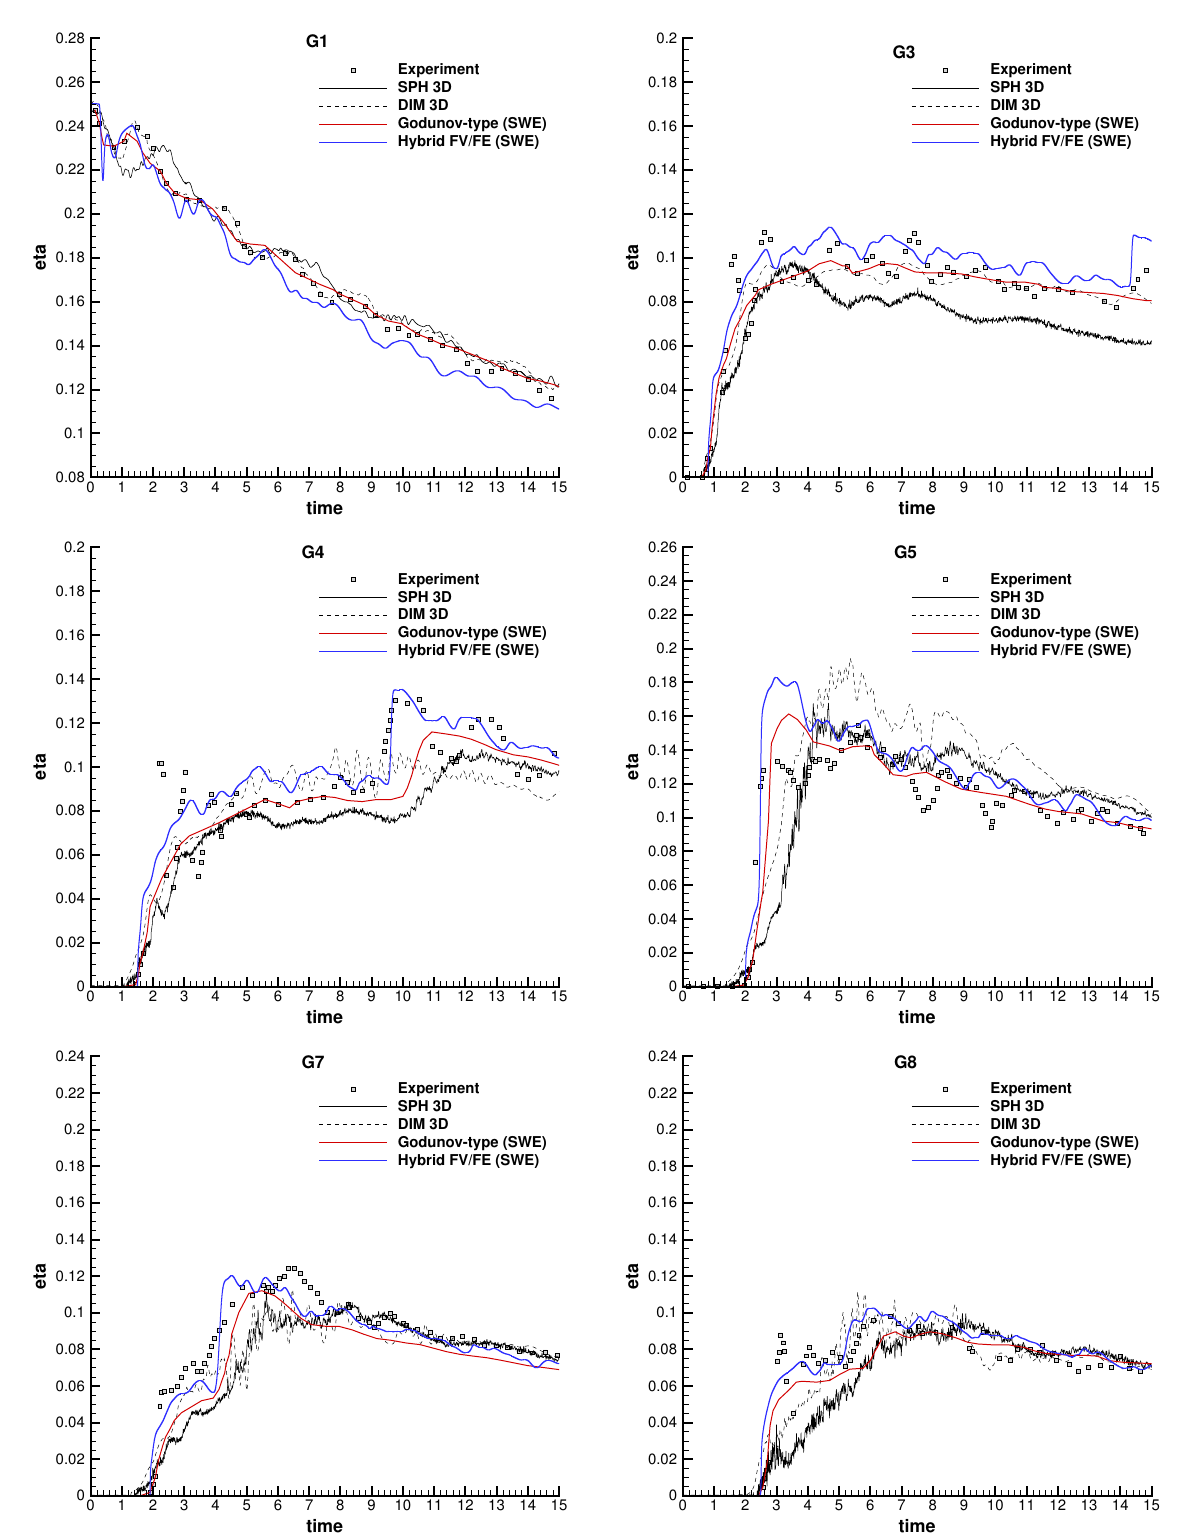
Figure 27. Time evolution of the free surface at wave gauges G1, G3, G4, G5, G7, G8 (from left top to right bottom ) for CADAM benchmark. Hybrid FV/FE scheme applied to the shallow water equations run in 2400 CPU cores (blue line); experimental results of Fraccarollo and Toro [102] (squares); explicit Godunov-type finite volume scheme (red line); fully nonhydrostatic 3D SPH scheme [106] (black dashed line); 3D diffuse interface method [104] (black